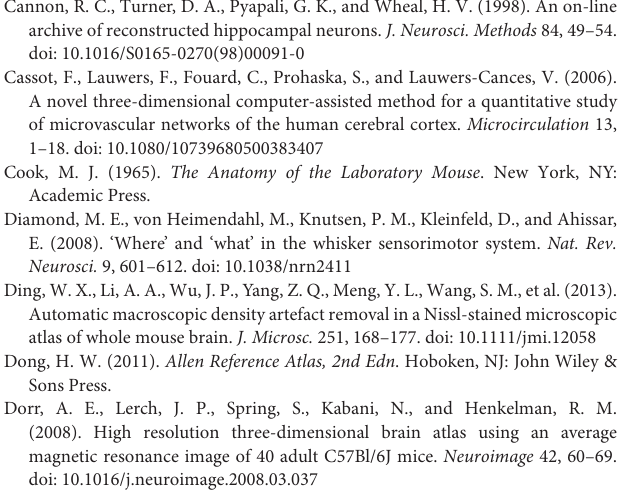
FIGURE 9 | in HIP with diameter size of 8 µ m (stack size of 400 400 400 µ m). (D,E) Quantitative statistical results for the fractional vascular volume (Fv) and × × normalized vascular length (Nl) in the S1BF, SC, HIP, TH, and HY. SD, small-sized vessel (D < 8 µ m) density; MD, medium-sized vessel (8 < D < 20 µ m); LD, large-sized vessel (D > 20 µ m) density. (F–H) The detailed diversity distributions ( P -values) among 5 brain regions of fv in SD, MD, and LD. (I–K) The detailed diversity distributions among 5 brain regions of nl in SD, MD, and LD; S1BF, primary somatosensory cortex, barrel field; SC, superior colliculus; HIP, hippocampus; TH, thalamus; HY,